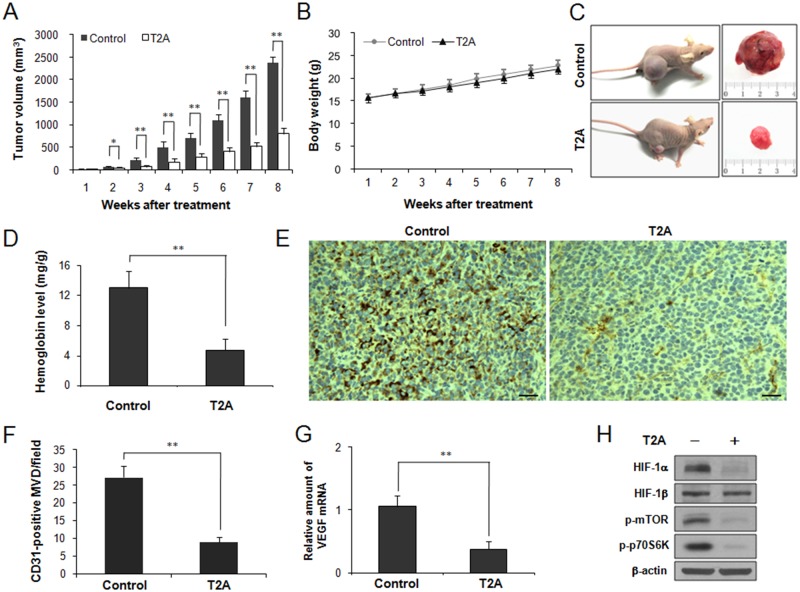
T2A inhibited angiogenesis and tumor growth in vivo.Xenograft mouse models on the back of nude mice were established using human MDA-MB-231 cells (2 × 106). Tumor mice were treated with T2A or vehicle as described in the Methods section. Tumor growth and body weight of mice were measured once a week. (A) Average tumor volume of vehicle control mice and mice treated with T2A. Values of tumor volume from the T2A-treated group were significantly reducted compared with those from mice of the control group based on Student’s t test; *P < 0.05 or **P < 0.01. (B) Body weight of mice during the eight weeks of T2A treatment. (C) Representative tumors from the control and T2A-treated groups. (D) Average hemoglobin levels in tumor tissues from 4 vehicle control and 4 T2A-treated mice. **P < 0.01 compared with vehicle control. (E) Representative tumor sections were immunostaining by using CD31 antibody. Scale bar represents 20 μm. (F) Microvessel density (MVD) was counted the CD31-positive blood vessels per field (400 × magnification) from four replicate tumor sections. **P < 0.01 compared with vehicle control. (G) Total cellular RNA were extracted from tumors in 4 vehicle control and 4 T2A-treated mice and the VEGF mRNA level was evaluated using real-time PCR. **P < 0.01 compared with vehicle control. (H) Tumors from 1 vehicle control mouse and 1 T2A-treated mice were surgically removed and homogenized. Whole tumor lysates were prepared and subjected to Western blot assay using antibodies as indicated.